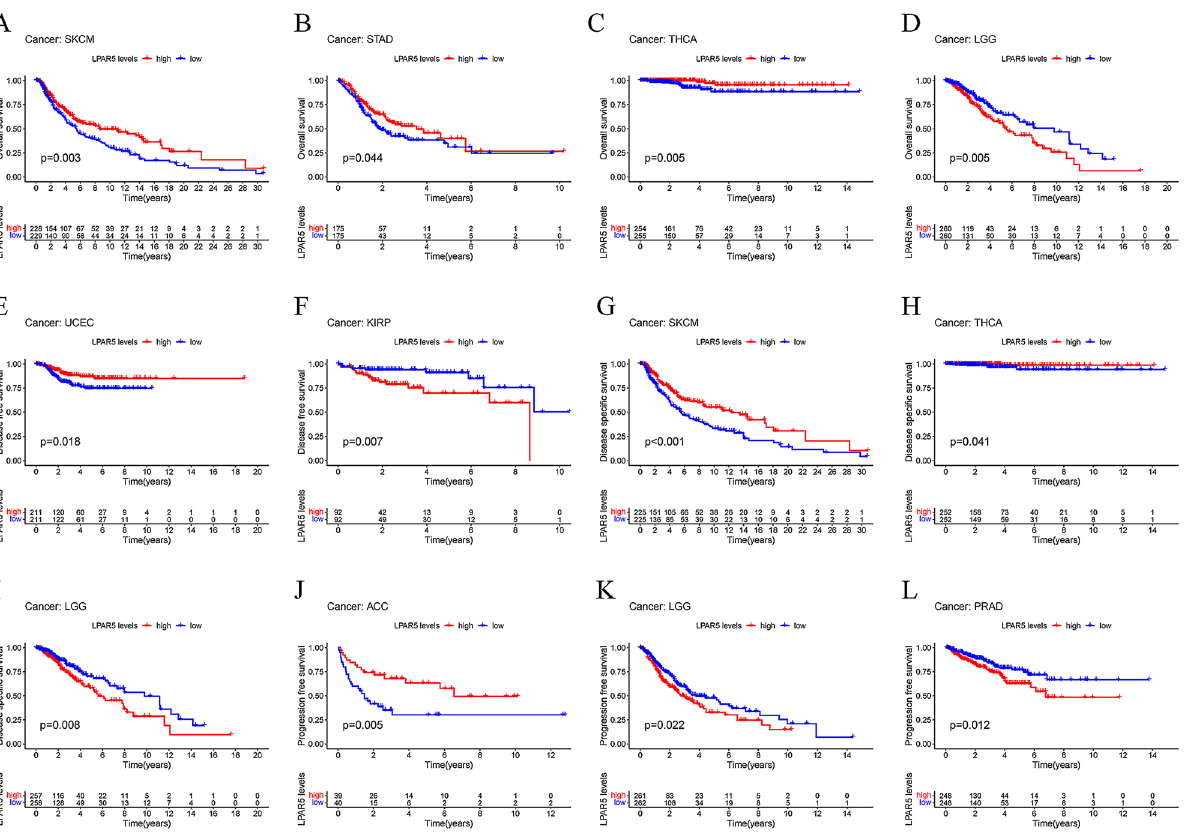
Figure 6. Survival analysis of 33 types of cancer. ( A – D ) The OS of SKCM, STAD, THCA, and LGG between high and low expression groups of LPAR5. ( E , F ) The DFS of UCEC and KIRP between high and low expression groups of LPAR5. ( G – I ) The DSS of SKCM, THCA, and LGG between high and low expression groups of LPAR5. ( J – L ) The PFS of ACC, LGG, and PRAD between high and low expression groups of LPAR5. [Figures created by R, version